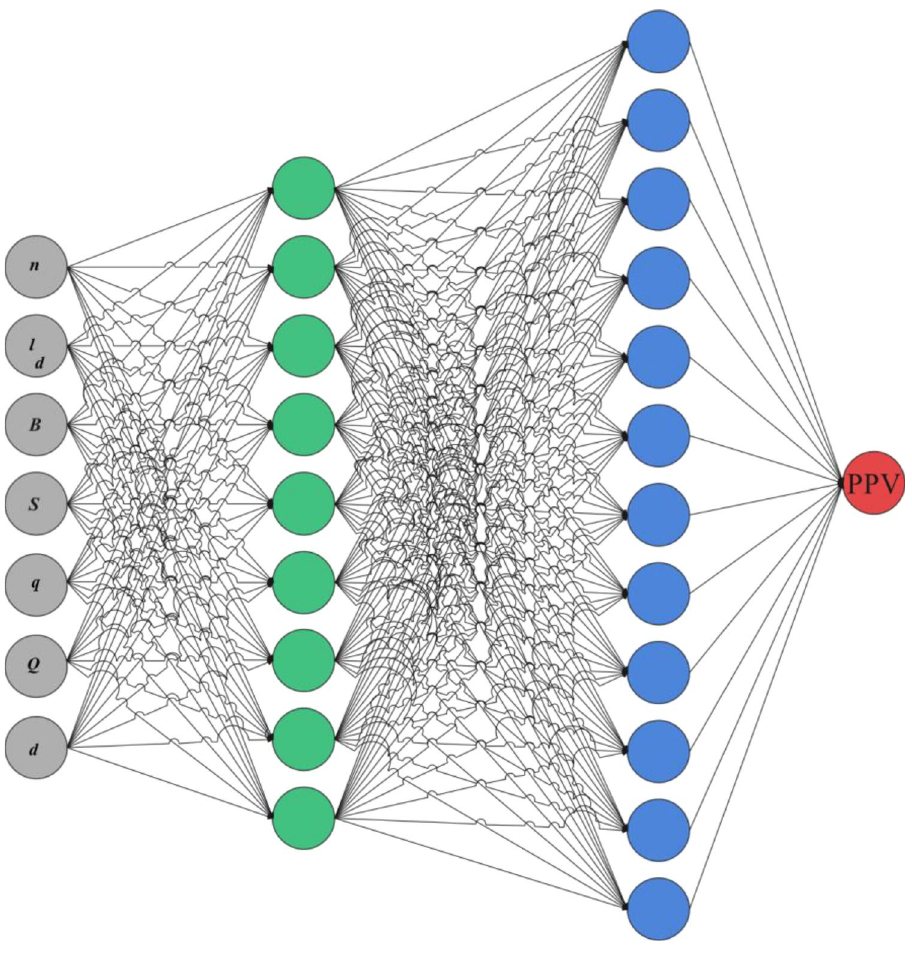
Figure 5. The architecture of the ensemble ANN model for PPV prediction in Anguran mine (this figure is generated by EdrawMax, version 12.0.7, www. edraw soft. com).